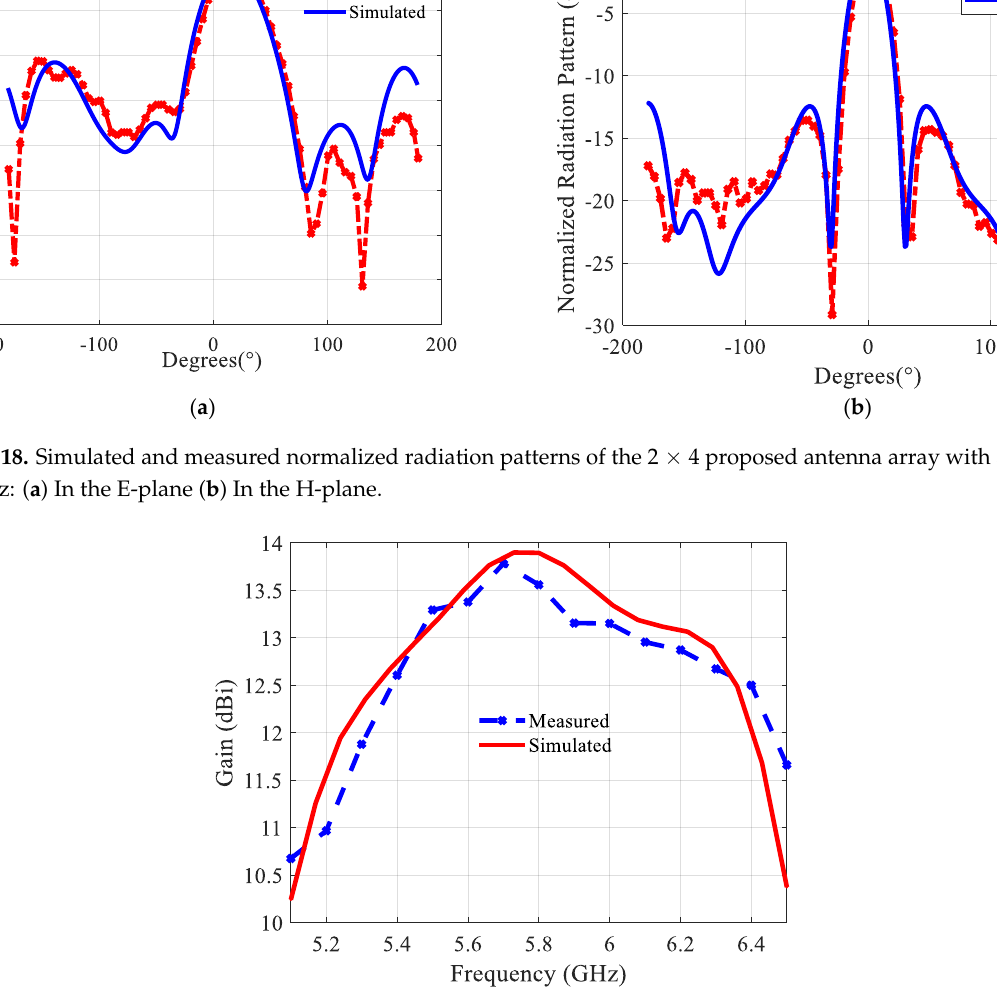
Figure 19. Simulated and measured gains.